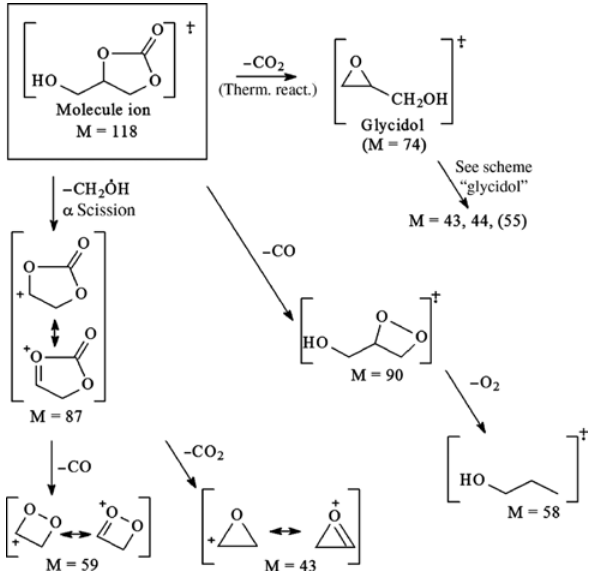
Figure 8: Most probable ions and their masses in the fragmentation of glycerin